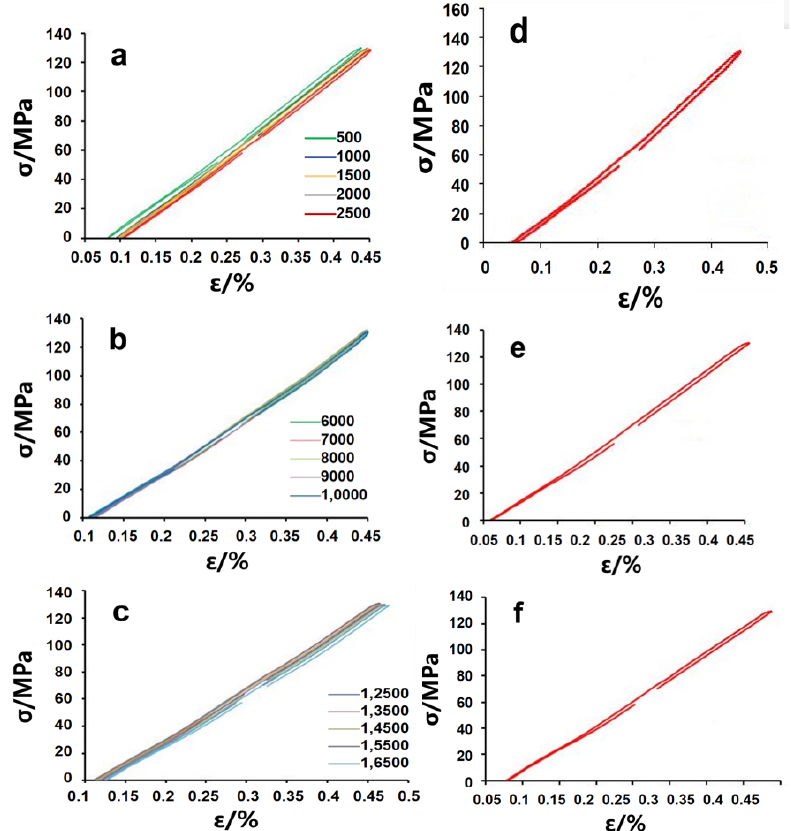
Figure 12. Hysteresis loop under 130 MPa: ( a ) initial stage; ( b ) stable stage; ( c ) late stage; ( d ) first cycle; ( e ) cycle 9180; ( f ) the last cycle.